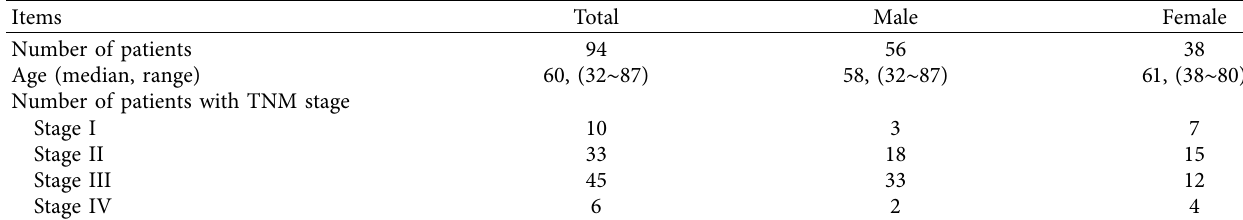
Table 3: The demographic and clinical chemistry characteristics of CRC